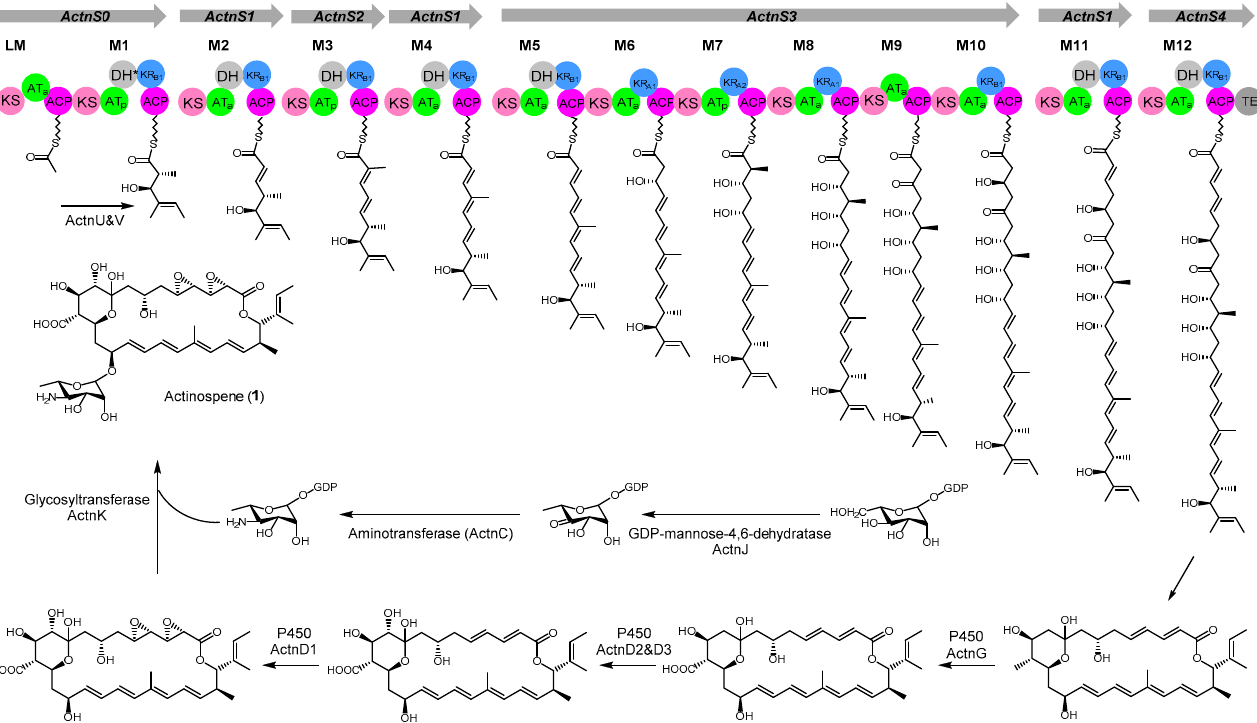
Figure 5. Proposed biosynthetic pathway for actinospene. Genes are shown as gray arrows, and modules of the biosynthetic machinery each containing a set of catalytic domains illustrated as circles (KS, ketoacyl synthase; AT, acyl transferase; ACP, acyl carrier protein; KR, β -ketoacyl reductase; DH, β -hydroxyacyl dehydratase; TE, thioesterase). AT and KR domains are shown with predicted stereochemistry based on sequence alignment (ATa, malonyl-CoA; ATp, methylmalonyl-CoA; KR A1 , A1-type ketoreductase; KR A2 , A2-type ketoreductase; KR B1 , B1-Type ketoreductase). * indicates an inactive DH domain.